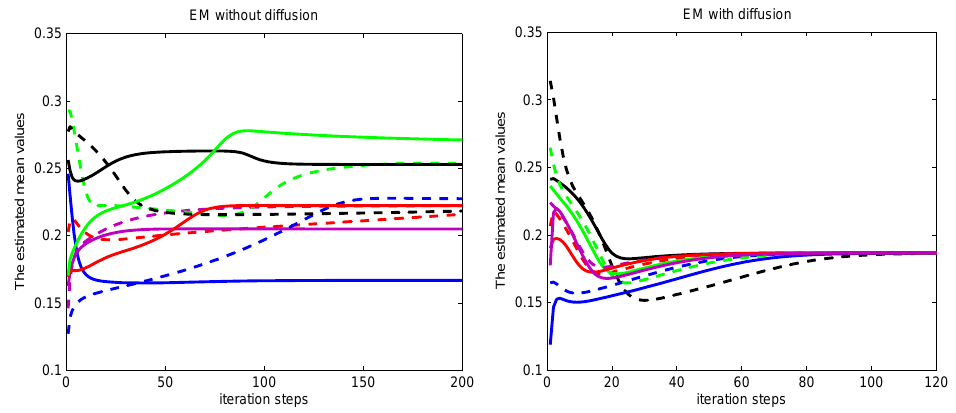
Figure 9. Estimated mean values by EM with and without